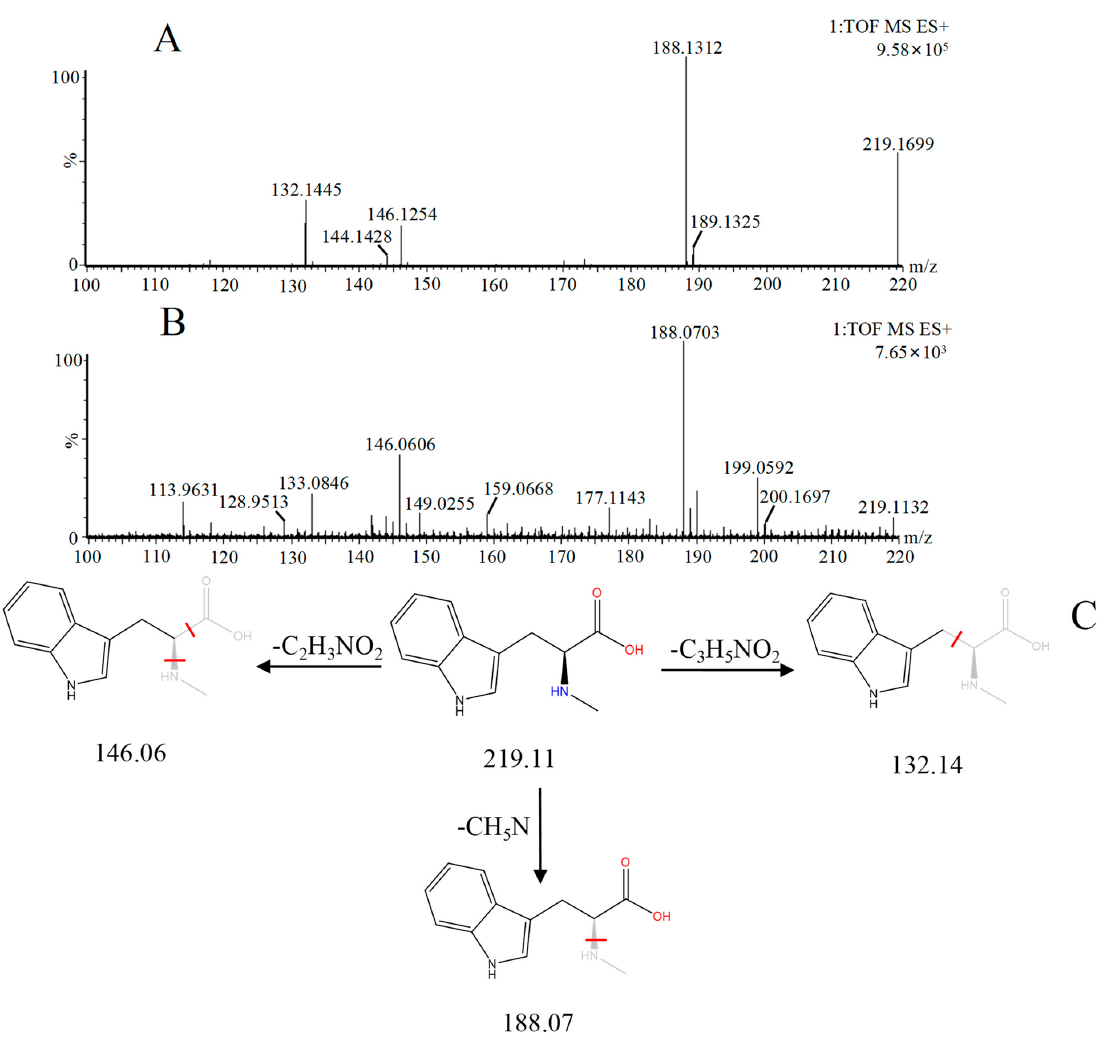
Figure 5. MS/MS fragment information and cleavage pathway of abrine. ( A ): MS/MS information of the abrine standard, ( B ): MS/MS information of abrine in serum samples, ( C ): the cleavage pathway of abrine. Table 1. The prototype blood components of JGCC.